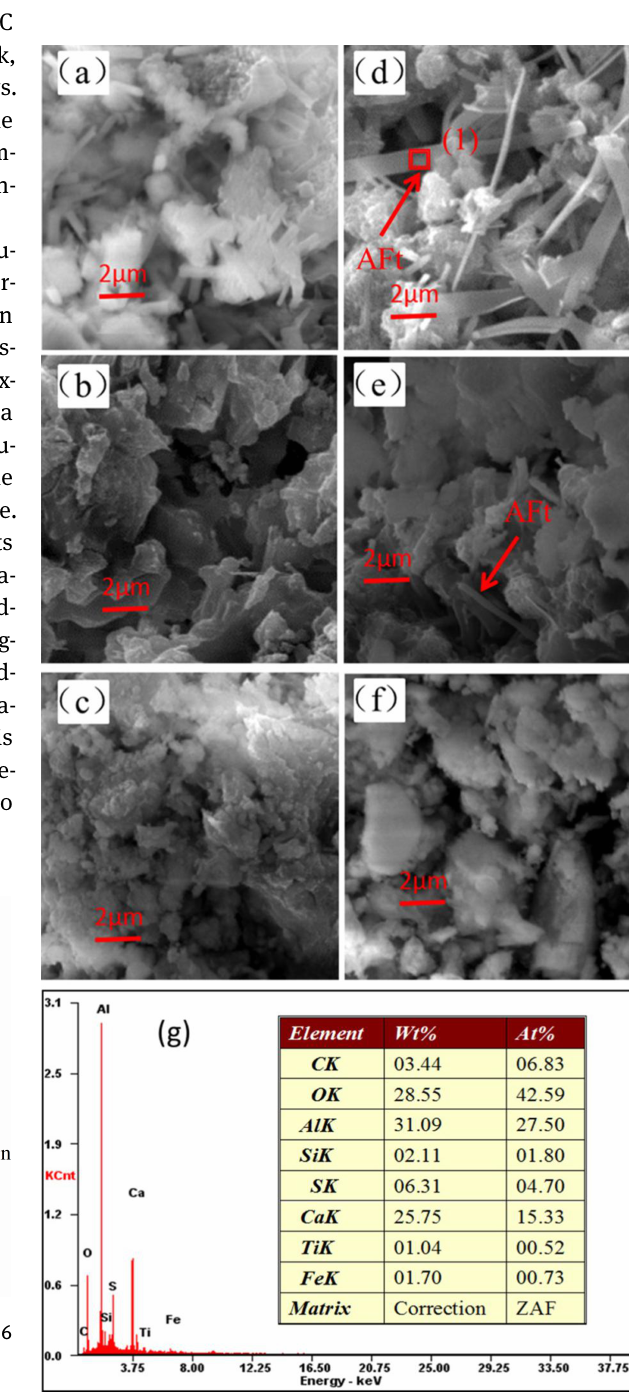
Figure 3: SEM images of SAC and GO-SAC at different ages.